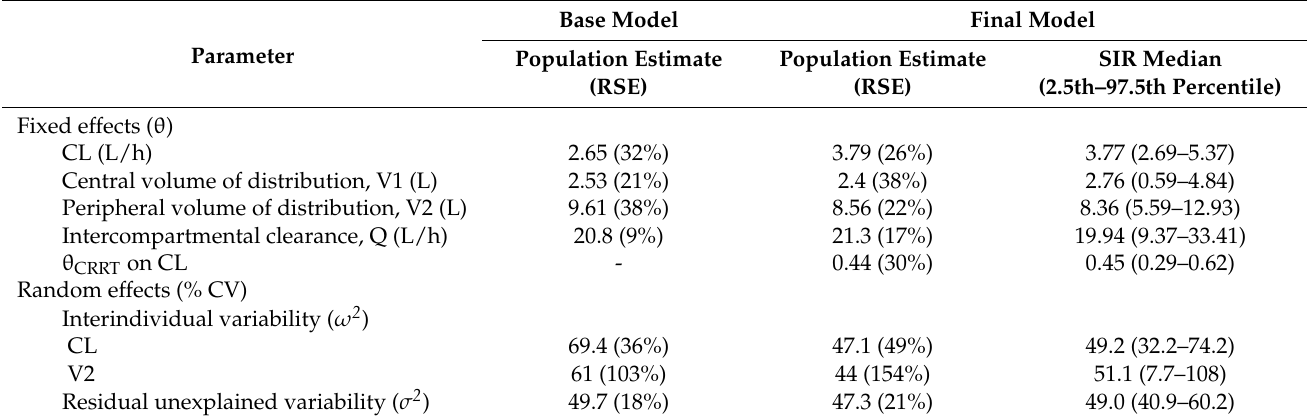
Table 2. Parameter estimates of the base model and final model.